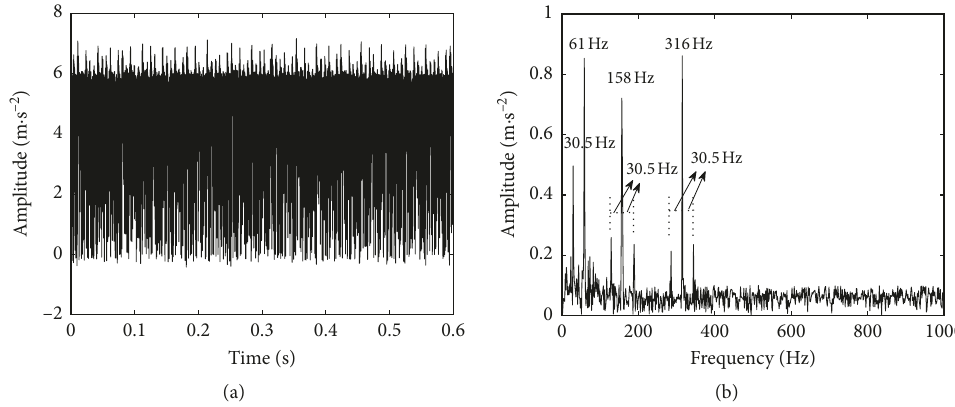
Figure 5: Erosion results of NQWSE. (a) Waveform in the time domain. (b) Frequency spectrum.